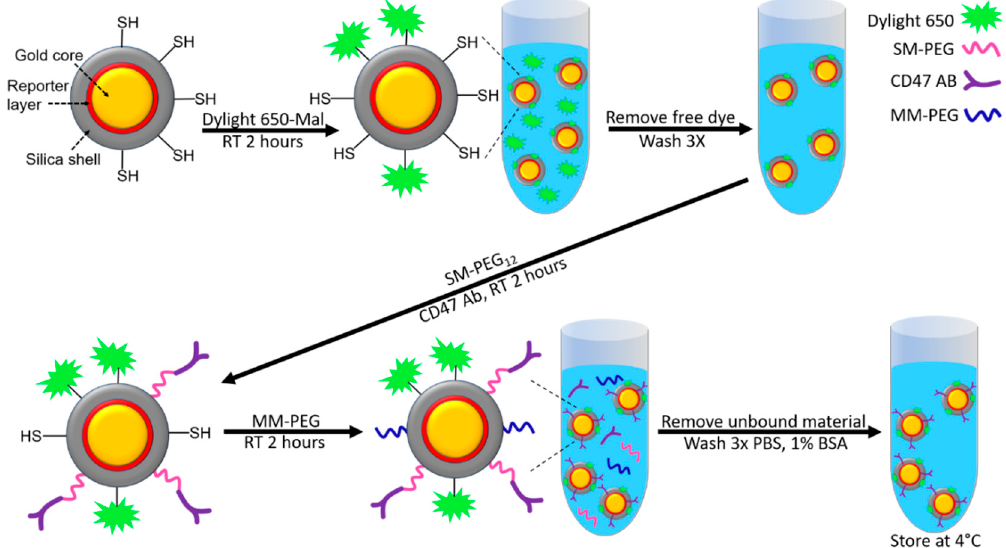
Figure 1. Schematic illustration of SERS NP conjugation with various elements, including Dylight 650 fluorophore, and PEGylated CD47 antibody.